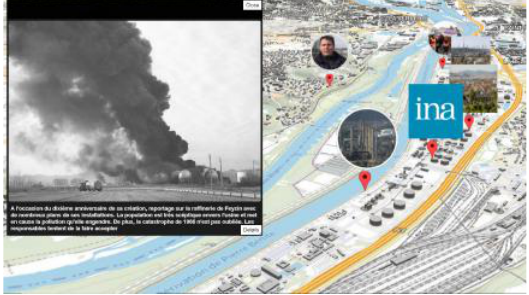
Figure 2. An example of the 3D geo-pinned multimedia approach. The pins show the available multimedia on the 3D scene while the selected document is shown on 2D at the left of the